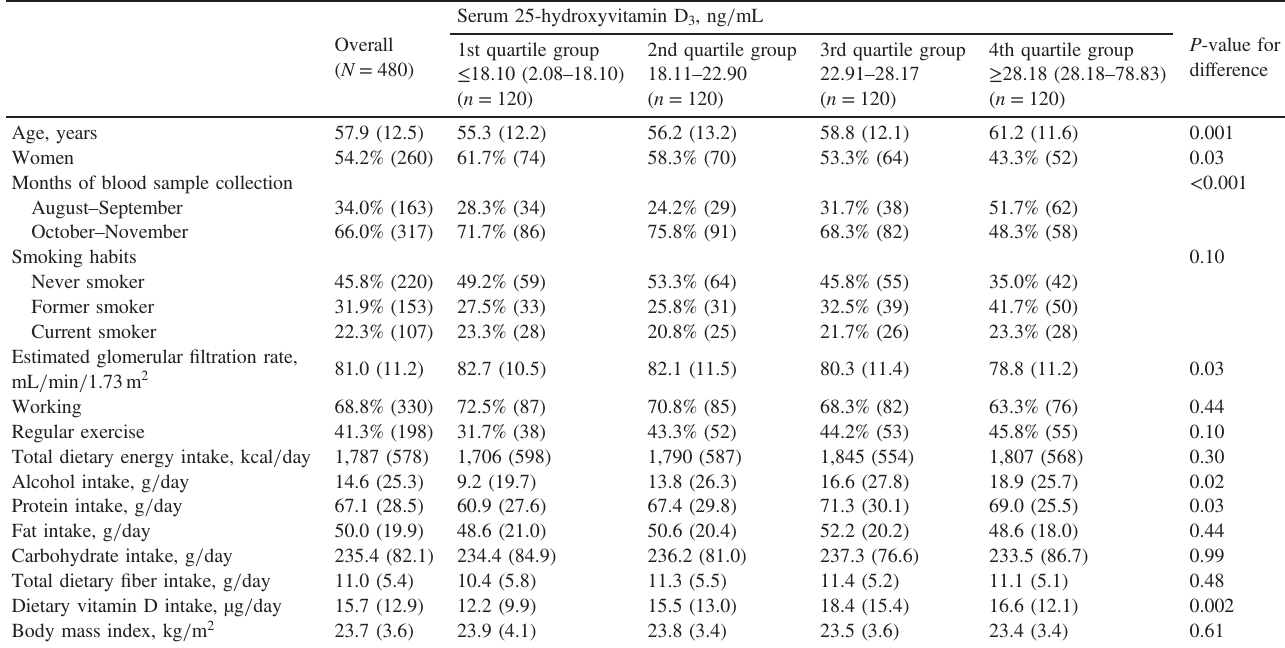
Table 1. Characteristics of study participants